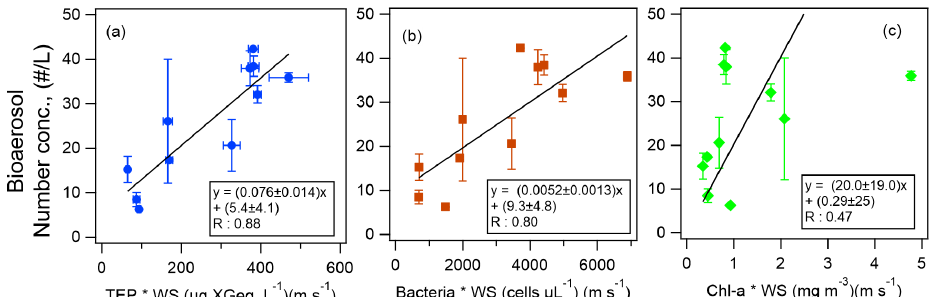
Figure 9. The scatter plots and equations of number concentrations of bioaerosols in the atmosphere as functions of the product of wind speed (WS) and the bioindicators of (a) TEP concentration, (b) bacteria concentration, and (c) Chl- a concentration. The black lines represent the orthogonal regression lines. The error bars represent 1 standard